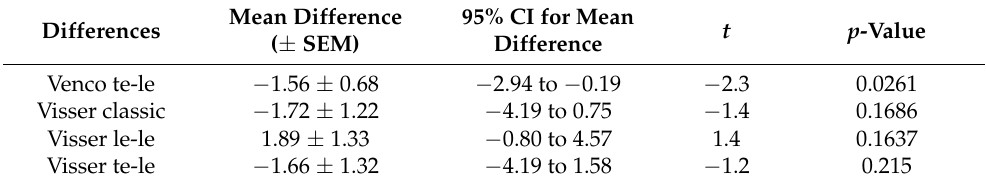
Table 3. Outcomes of analysis of differences by one-sample t -test for fixed bias.